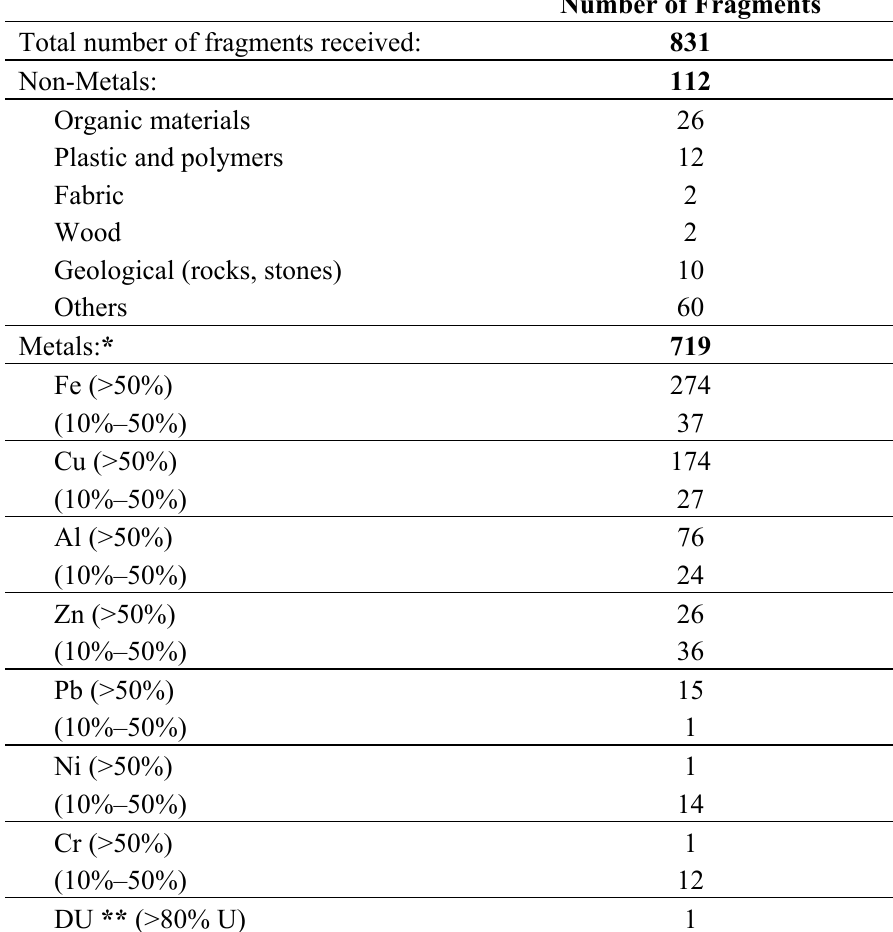
Table 1. Composition of fragments in the Joint Pathology Center Embedded Metal Fragment Registry. Number of